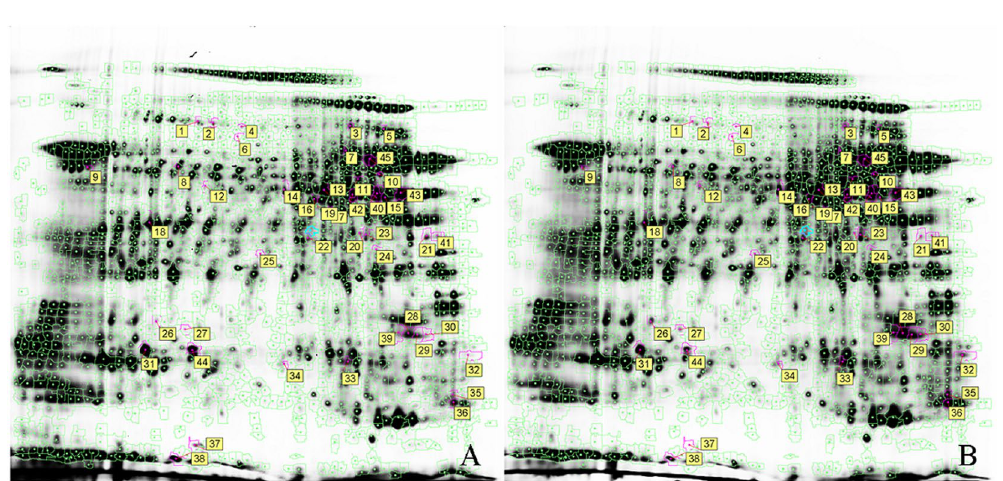
Figure 2. The distribution of differential expression proteins. Figure A&B shown the distribution of differential proteins in high-fecundity group and low-fecundity group separately. Pink cycles shown the protein spots with statistically significance. Analyzed by DeCyder Differential Analysis Software (paired t-test, p <